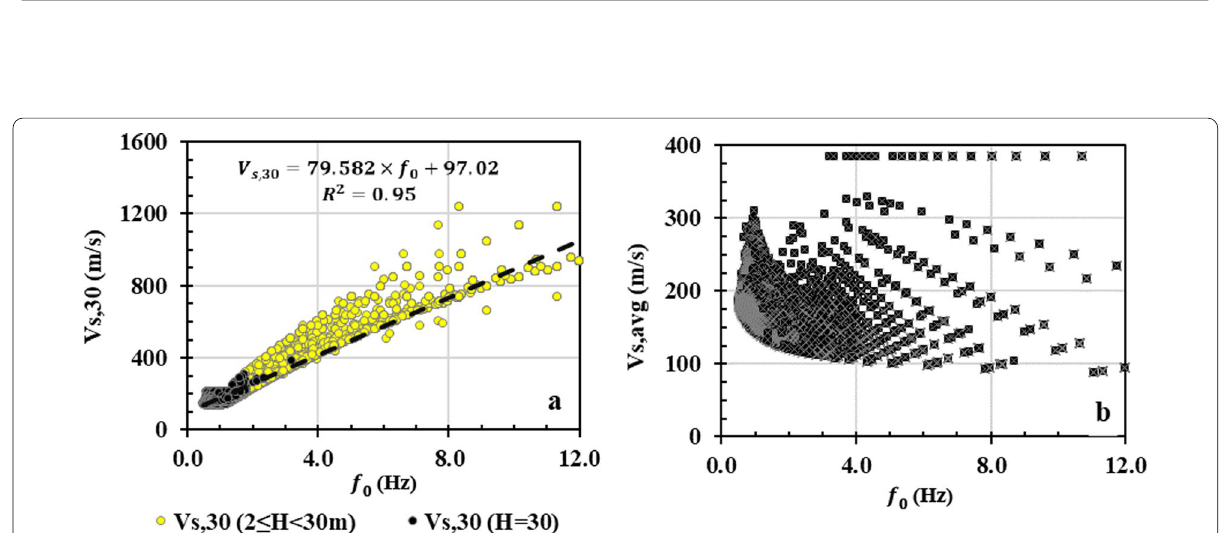
Fig. 7 Correlation of the fundamental site frequency f 0 with a V S,30 , and b V